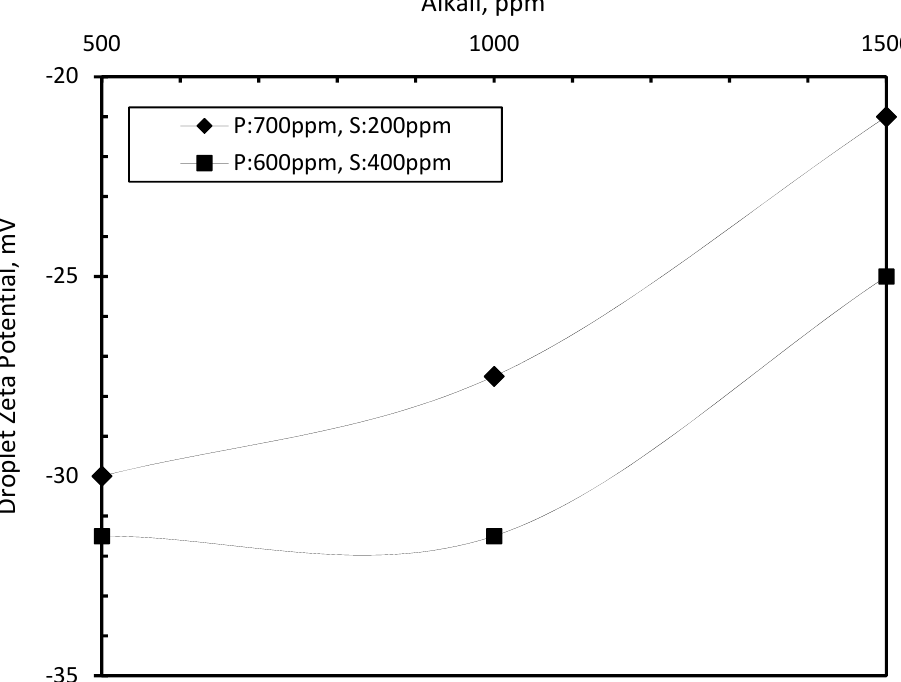
Figure 12. Zeta potential of the droplets with a Malvern particle analyzer.